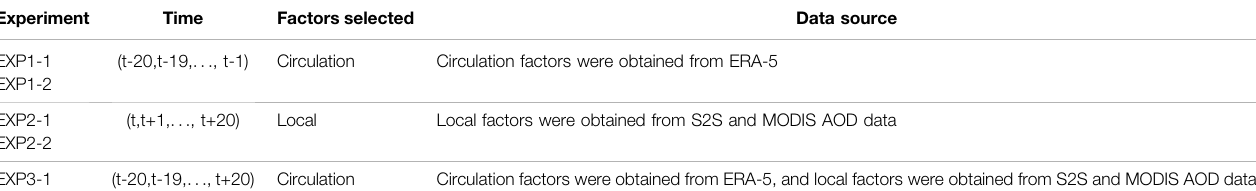
TABLE 3 | Experimental design.